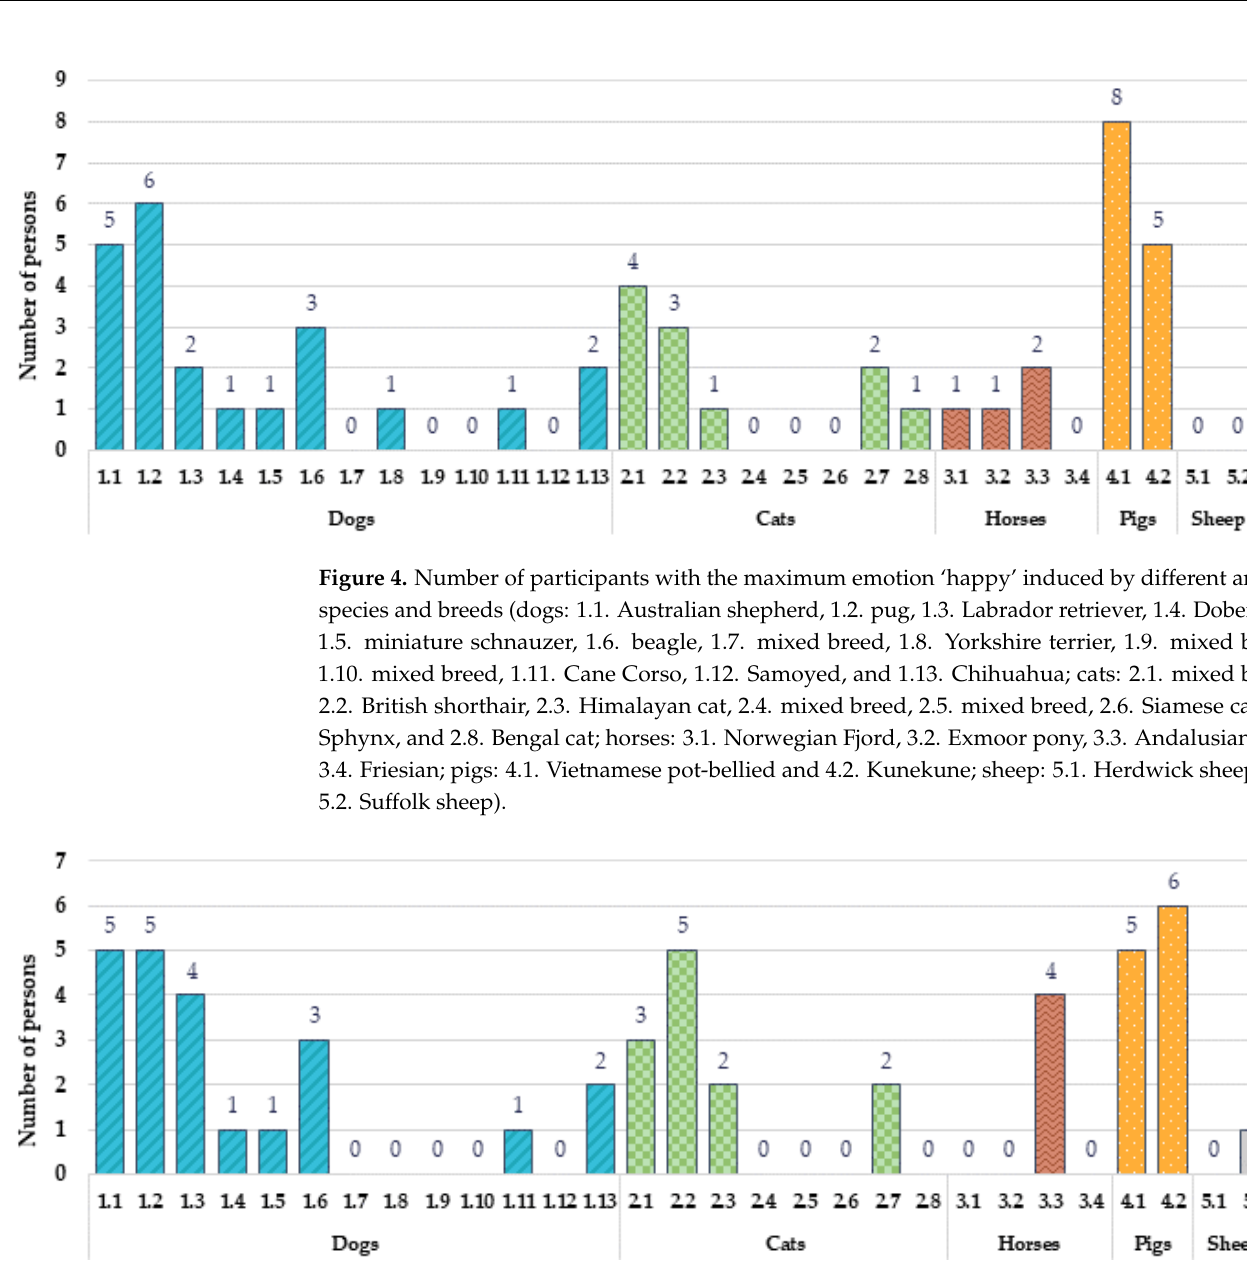
Figure 5. Number of the participants with the maximum valence induced by different animal species and breeds (dogs: 1.1. Australian shepherd, 1.2. pug, 1.3. Labrador retriever, 1.4. Doberman, 1.5. miniature schnauzer, 1.6. beagle, 1.7. mixed breed, 1.8. Yorkshire terrier, 1.9. mixed breed, 1.10. mixed breed, 1.11. Cane Corso, 1.12. Samoyed, and 1.13. Chihuahua; cats: 2.1. mixed breed, 2.2. British shorthair, 2.3. Himalayan cat, 2.4. mixed breed, 2.5. mixed breed, 2.6. Siamese cat, 2.7. Sphynx, and 2.8. Bengal cat; horses: 3.1. Norwegian Fjord, 3.2. Exmoor pony, 3.3. Andalusian, and 3.4. Friesian; pigs: 4.1. Vietnamese pot-bellied and 4.2. Kunekune; sheep: 5.1. Herdwick sheep and 5.2. Suffolk sheep).